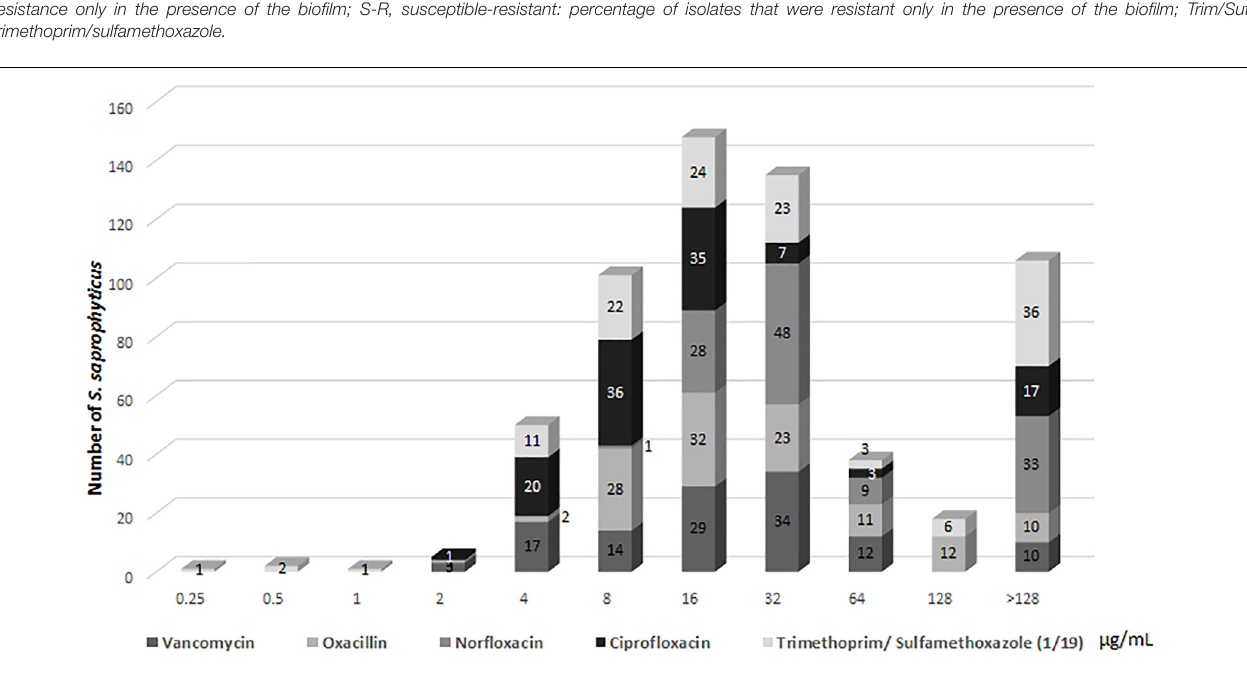
FIGURE 3 | Profile of (MBCB) of Staphylococcus